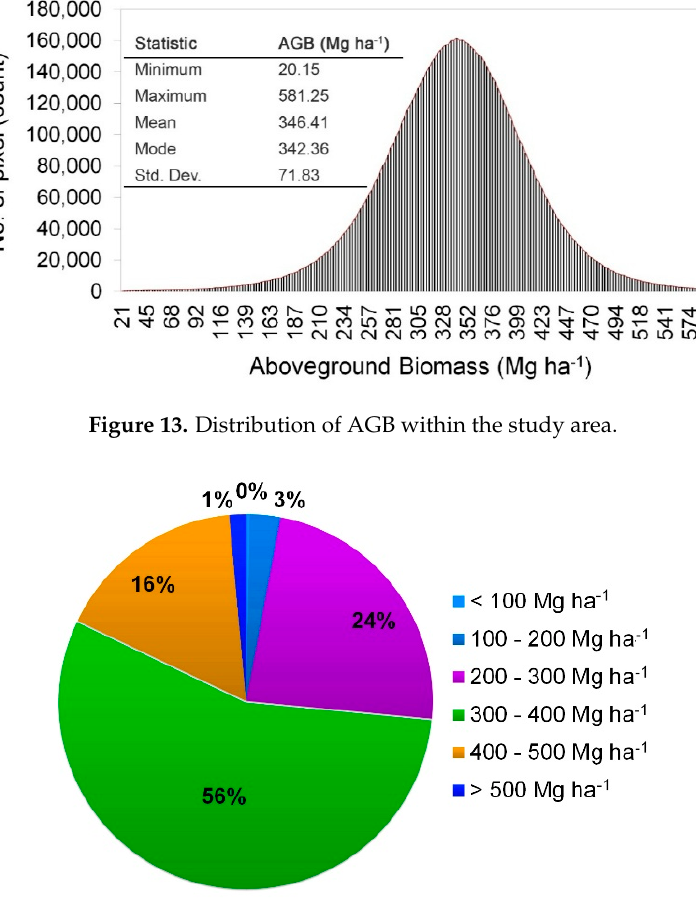
Figure 14. Overall breakdowns of AGB density in the study area.